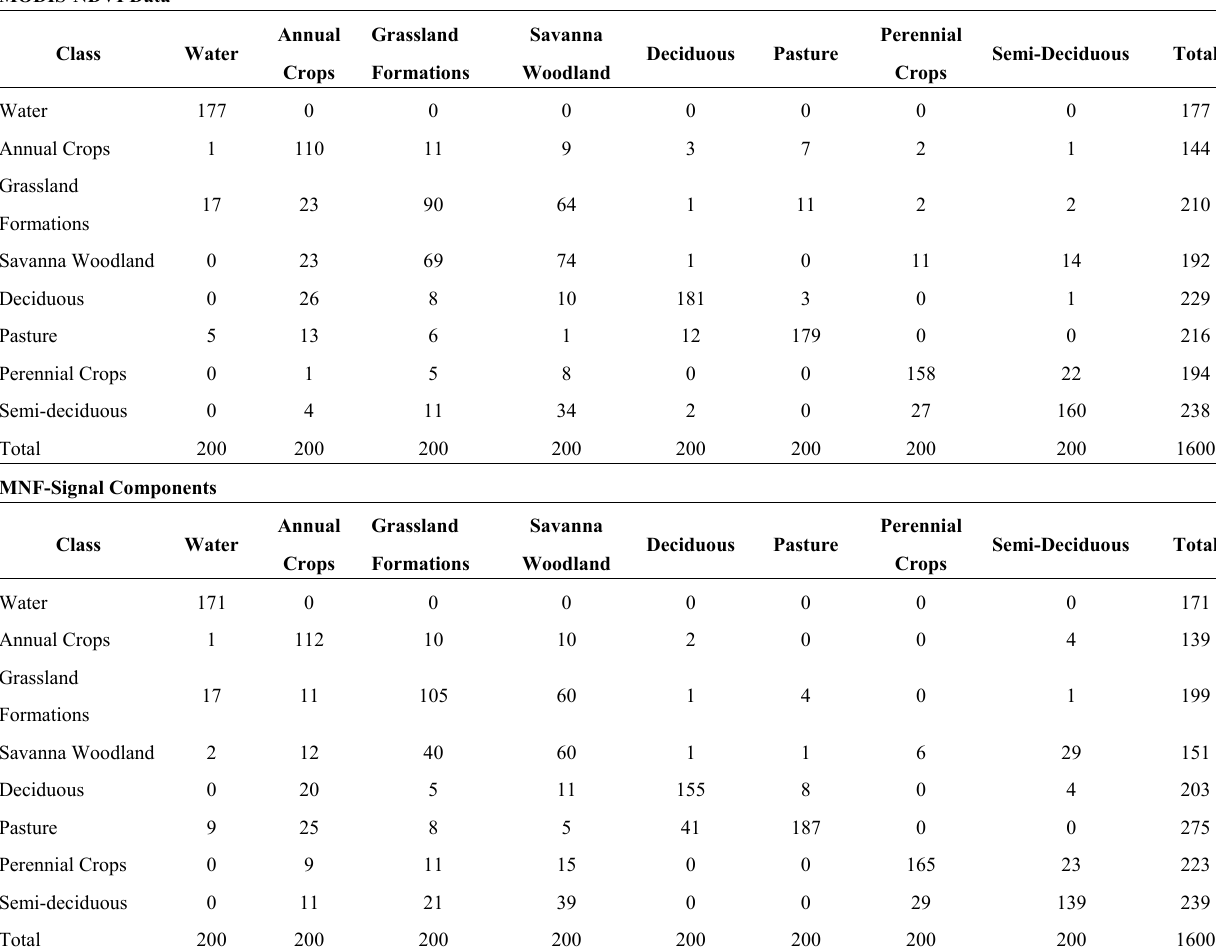
Table 5. Confusion matrices for the classifications based on the ED and eight mapping classes from the MODIS-NDVI data and MNF-signal